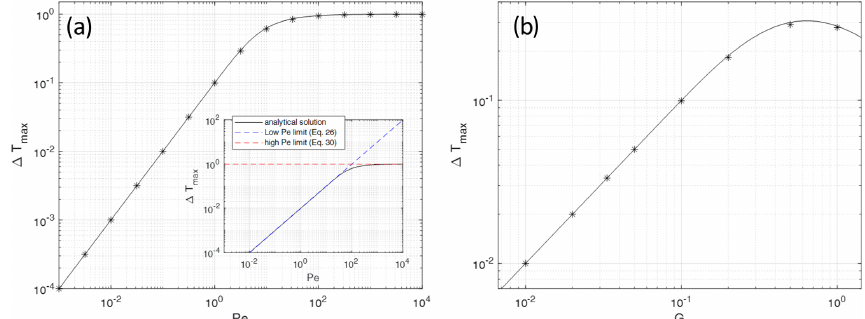
Figure 3. Maximum fluid–solid temperature differences T f − T s of numerical models (asterisks) with different parameters, plotted (a) as a function of the Péclet number Pe for G = 0 . 1 and φ = 0 . 1 and (b) as a function of the initial thermal gradient G for Pe = 1 and φ = 0 . 1. The solid lines give the analytic solutions. The inset in (a) shows the comparison of the analytic solution Eq. (22) with the different limits derived in Sect. 2.1 and 2.2. The black curve represents the analytic solution, and the colored straight lines show the results in the high or low value limits of Eqs. (26) to (30), respectively. A larger version of the inset is given as Fig. S1 in the Supplement. The analytical solution for the full parameter range Pe – G is given in Fig.